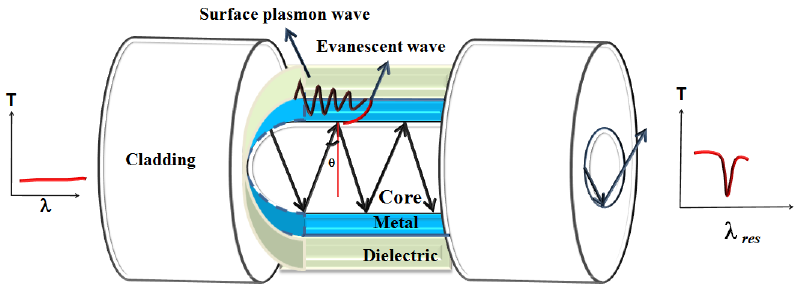
Figure 2. The general optic fiber-based configuration for excitation of SPR.